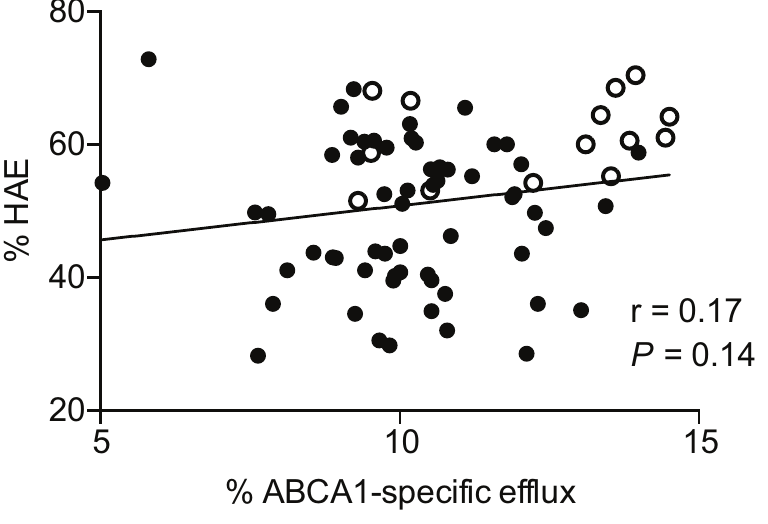
Fig 2. Correlation of ABCA1-specific CEC and HAE. Correlation was determinedby linear regression analysisusing Pearson’scorrelationcoefficicent. ( ● ) MetSyn (o) Control. Exclusionof one subject with HAE of 72.8% and ABCA1-specific CEC of 5.8% yields a significantrelationship where r = 0.26, P = 0.03.